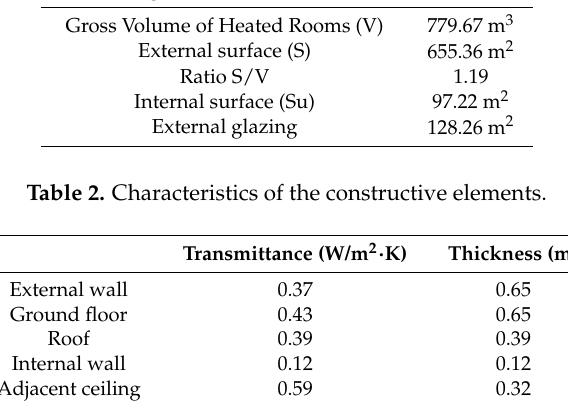
Figure 1. Building outside view and Sketchup model. Table 1. Geometrical data.